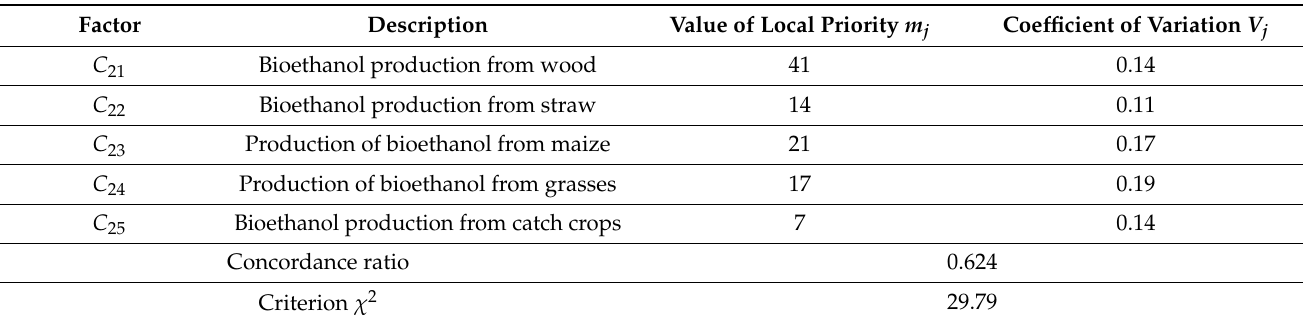
Table 2. Assessment of the importance of level II factors conditioning the development of second- generation bioethanol production in